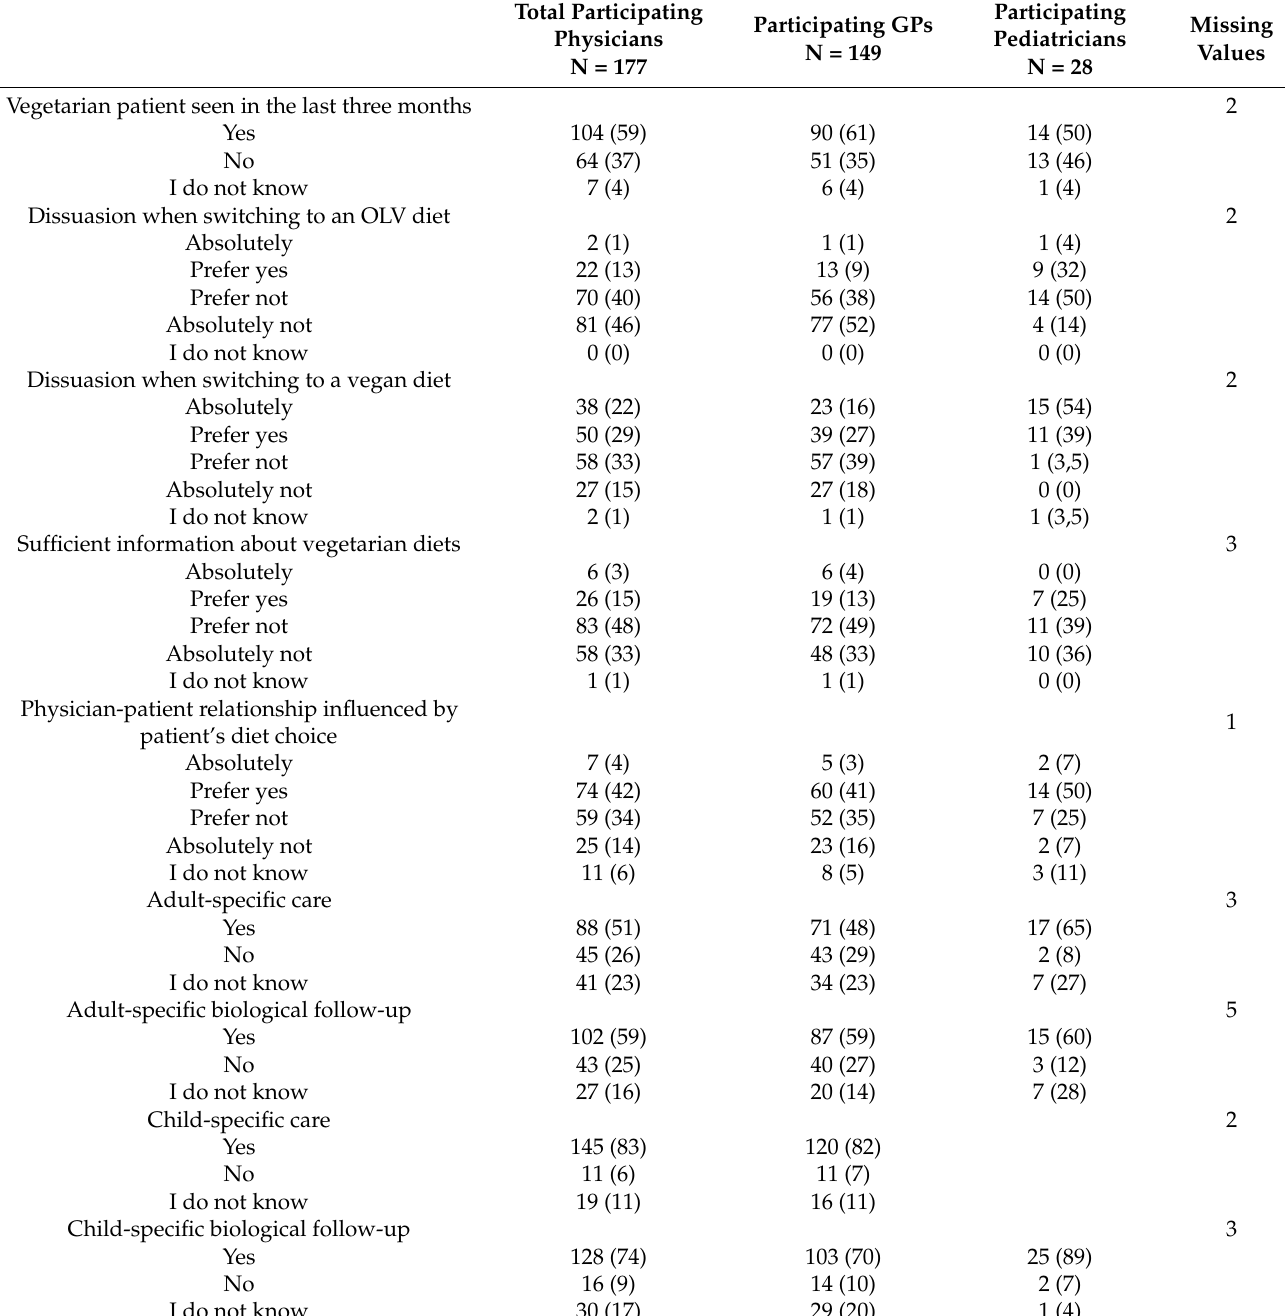
Table 3. Vegetarian diets and physician–patient relationships n